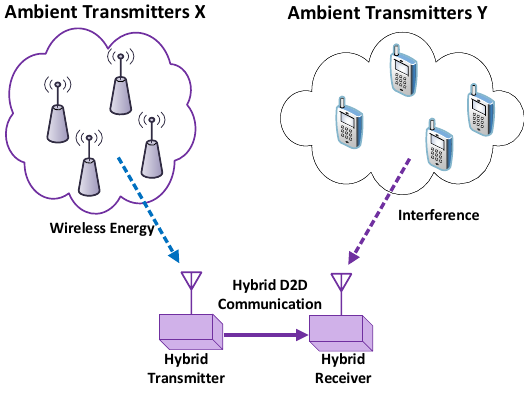
Figure 38. Hybrid D2D